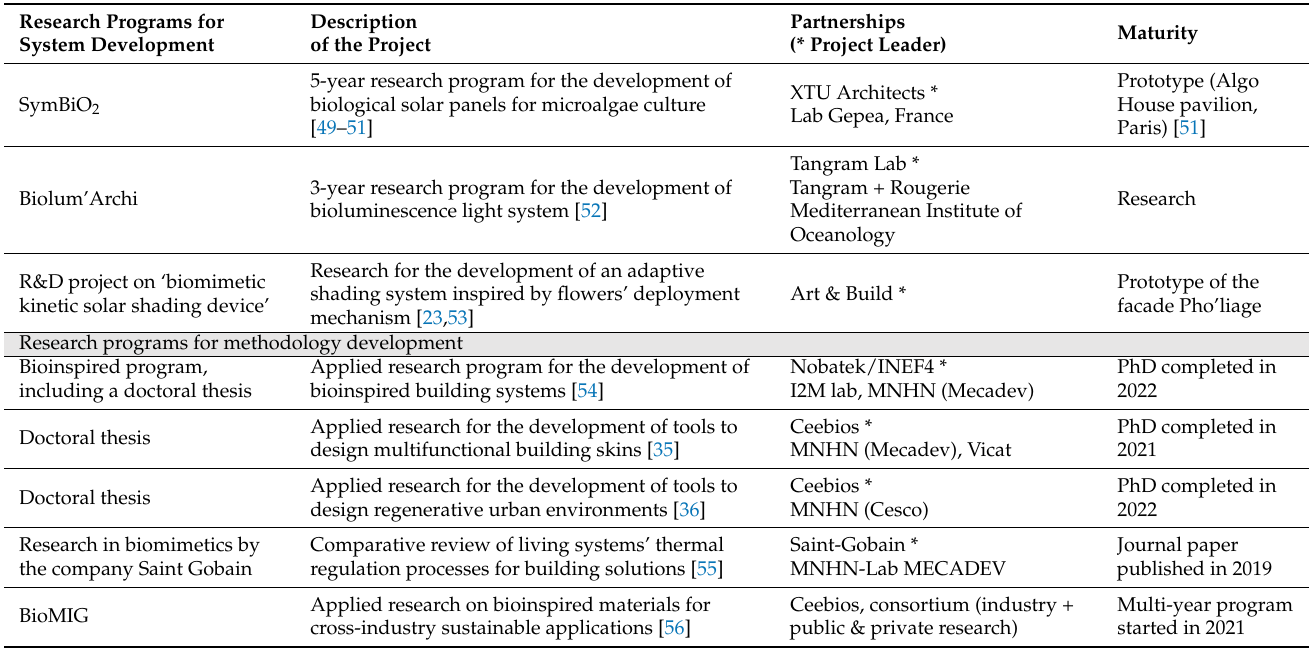
Table 2. Examples of French academic and industrial research programs in biomimicry for the built environment carried out over the last ten years. (*) indicates the organization that initiates the